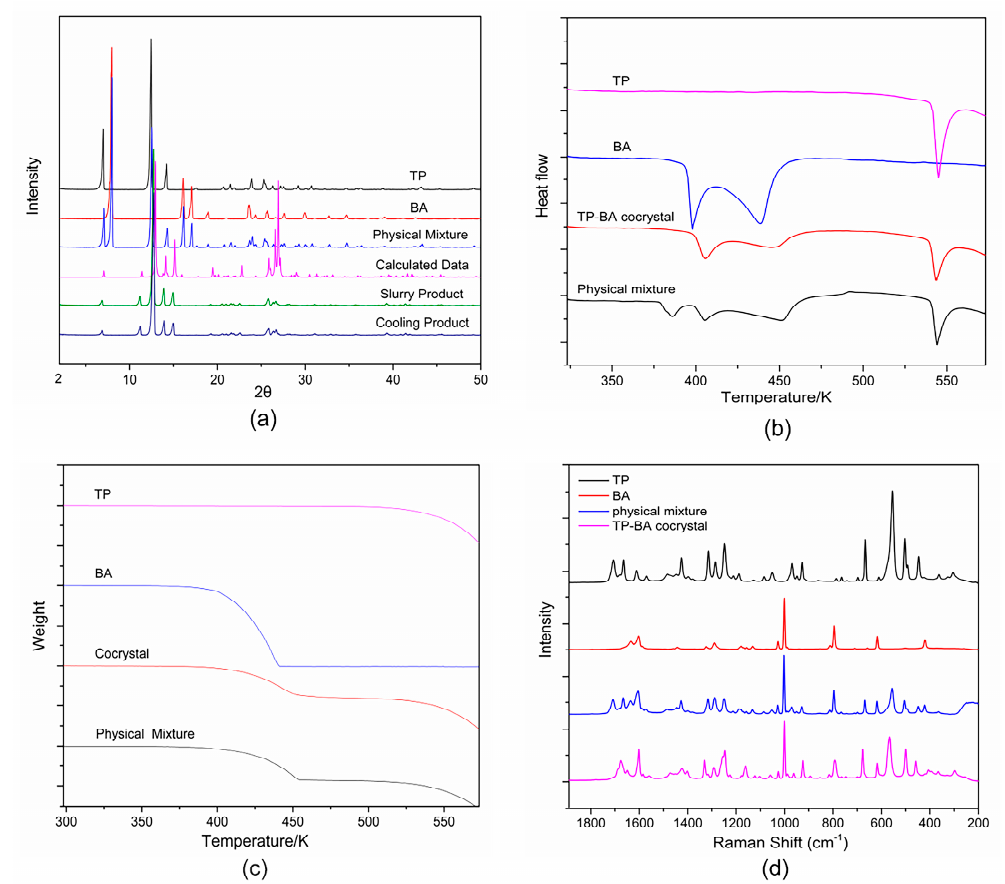
Figure 2. The solid characterization spectra of TP, BA, physical mixture and TP-BA cocrystal: ( a ) powder X-ray diffraction (PXRD); ( b ) differential scanning calorimetry (DSC); ( c ) thermogravimetric analysis (TGA); (d) Raman spectroscopy.